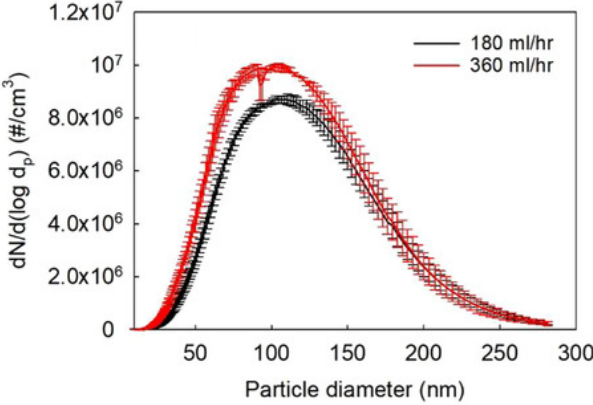
Figure 11. Particle size distribution of alumina NPs produced through flame synthesis at different precursor feed flow rates [18]. Reproduced with permission from Okonkwo, O., et al., Journal of the American Ceramic Society; published by The American Ceramic Society, 2021. 943